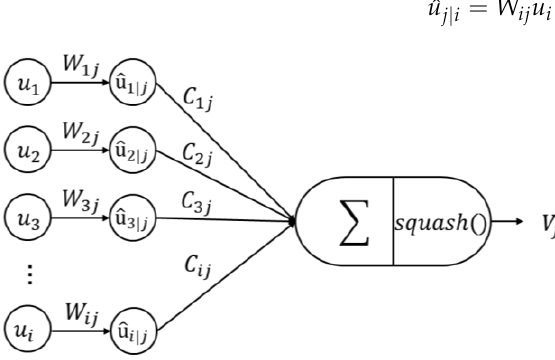
Figure 9. The figure of